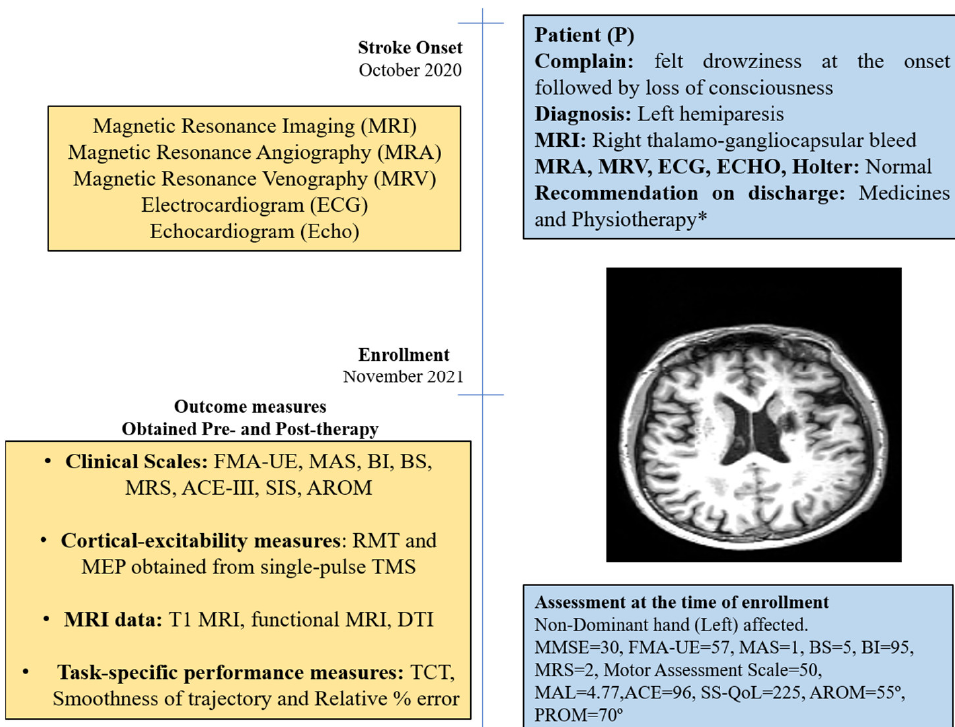
Figure 1. Timeline with relevant data from the episodes of care and clinical assessment scores obtained at the time of enrollment. * Details in Supplementary